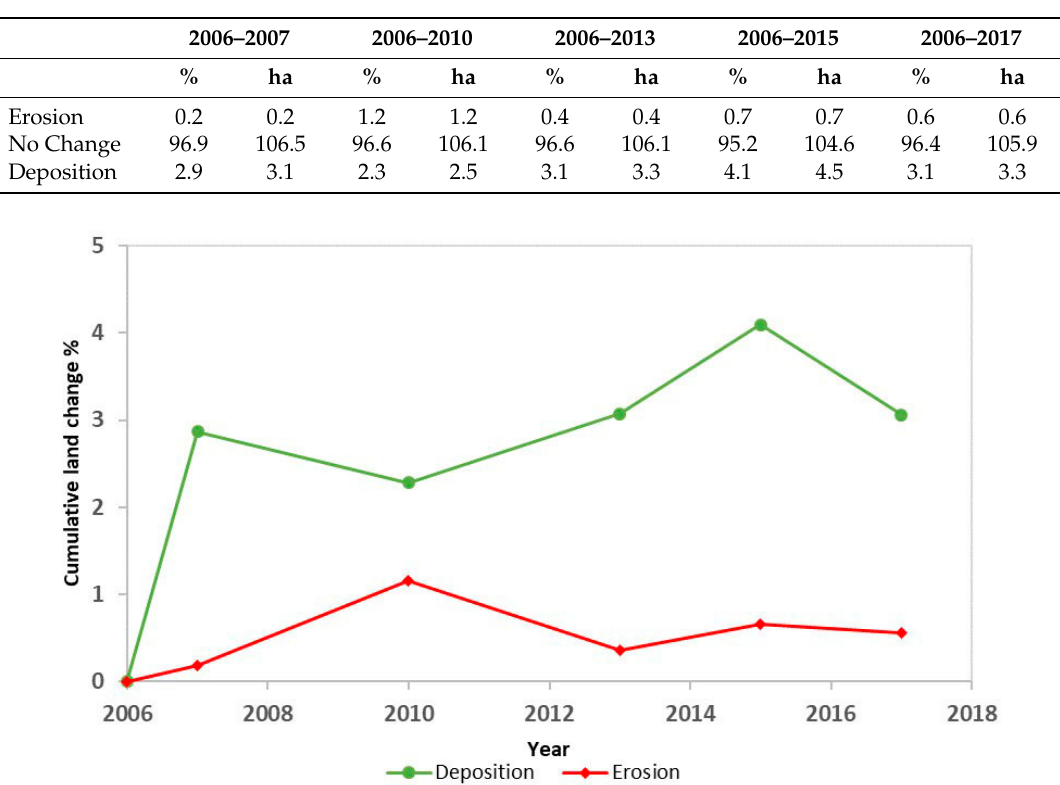
Figure 3. Trend graph showing cumulative marsh terrace performance from 2006–2017 of C3 terrace field of study.